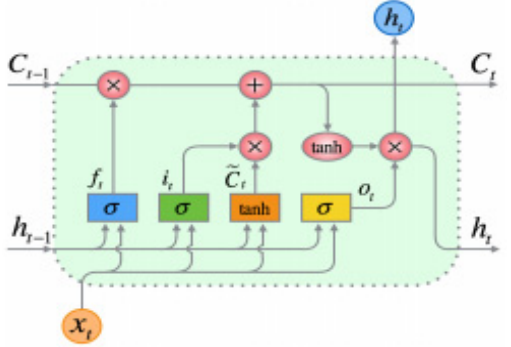
Figure 8. Overview of LSTM architecture [40].